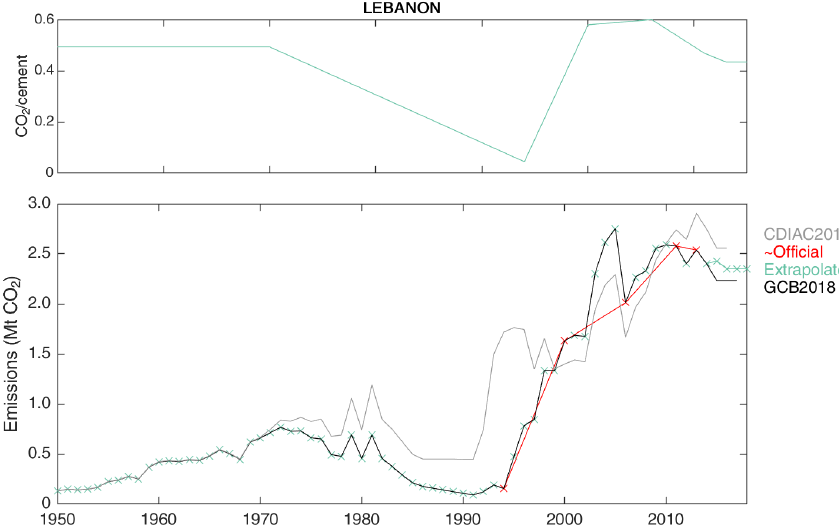
Figure C27. Revised cement emissions in Lebanon.